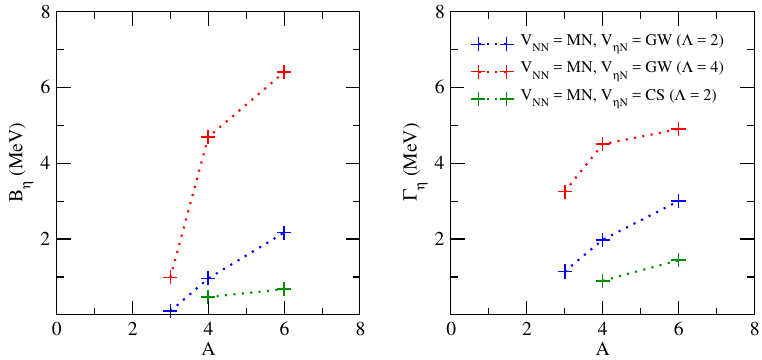
Figure 1. SVM calculations of the binding energy B η and width Γ η in η 3 He, η 4 He, and η 6 Li using the Minnesota NN potential with Coulomb force included and two η N interaction models - GW and CS.